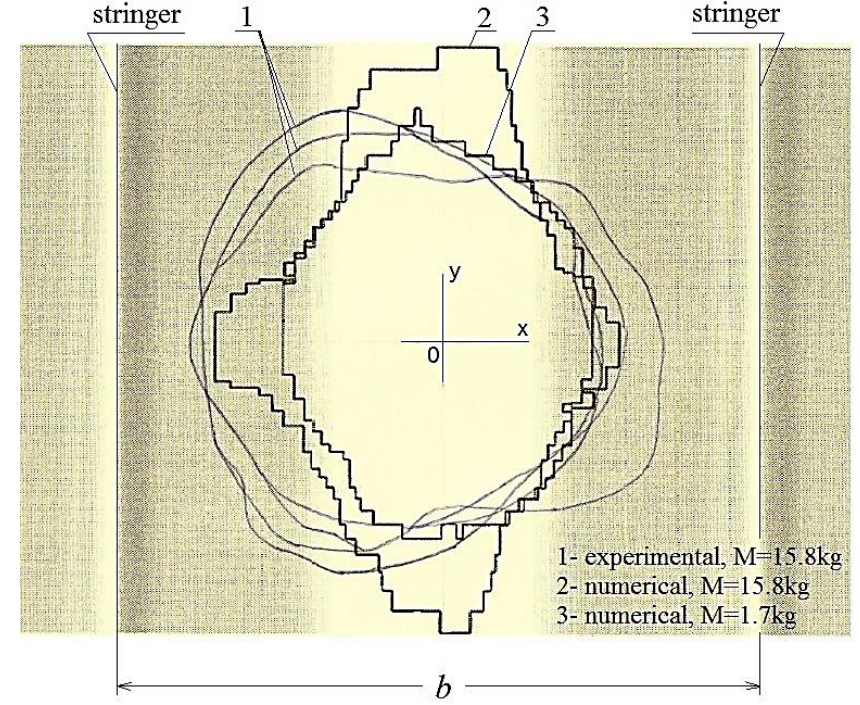
Figure 4. Experimental and numerical damage zones.